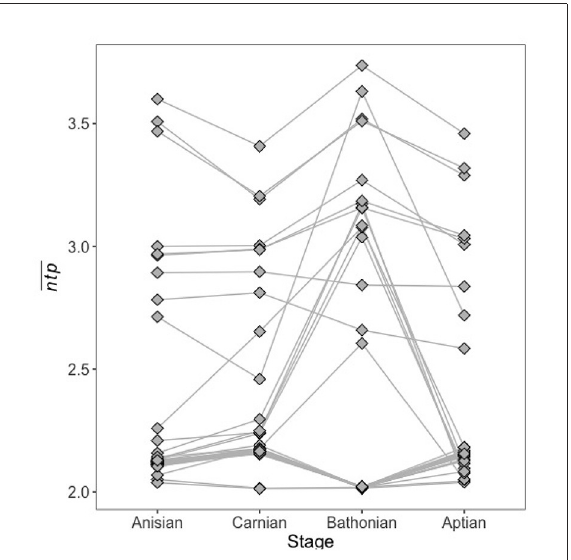
FIGURE6 Guild ntp for guilds that occurred in all four stages. ntp for the same guild may vary greatly depending on what other guilds are present in the community at the same time.